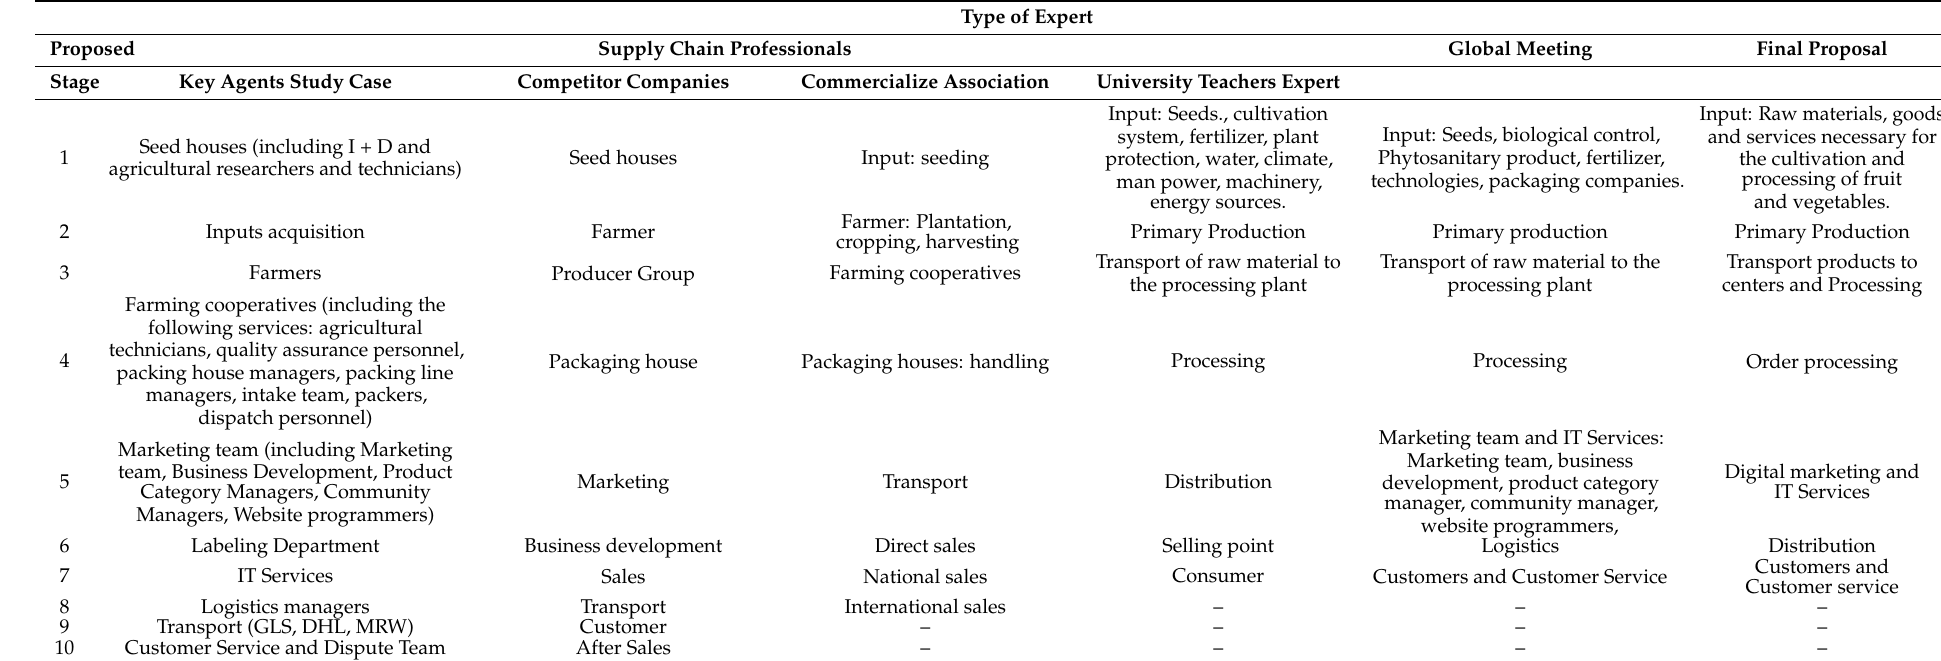
Table 2. Proposed ASC